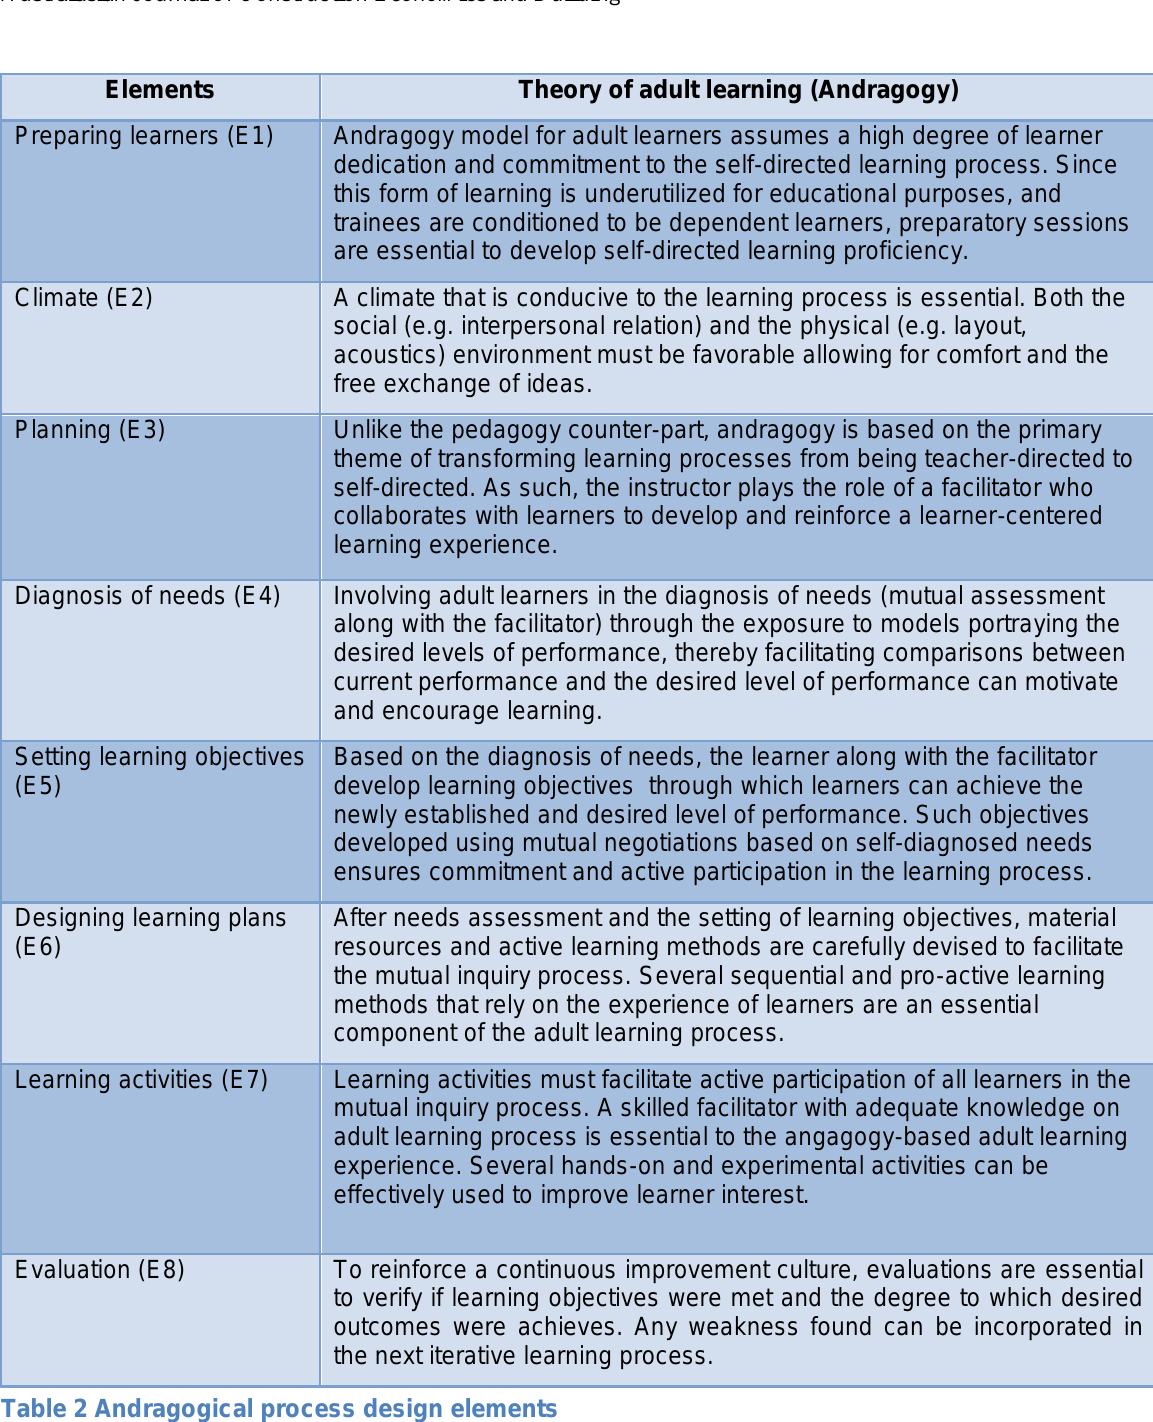
Table 2 Andragogical process design